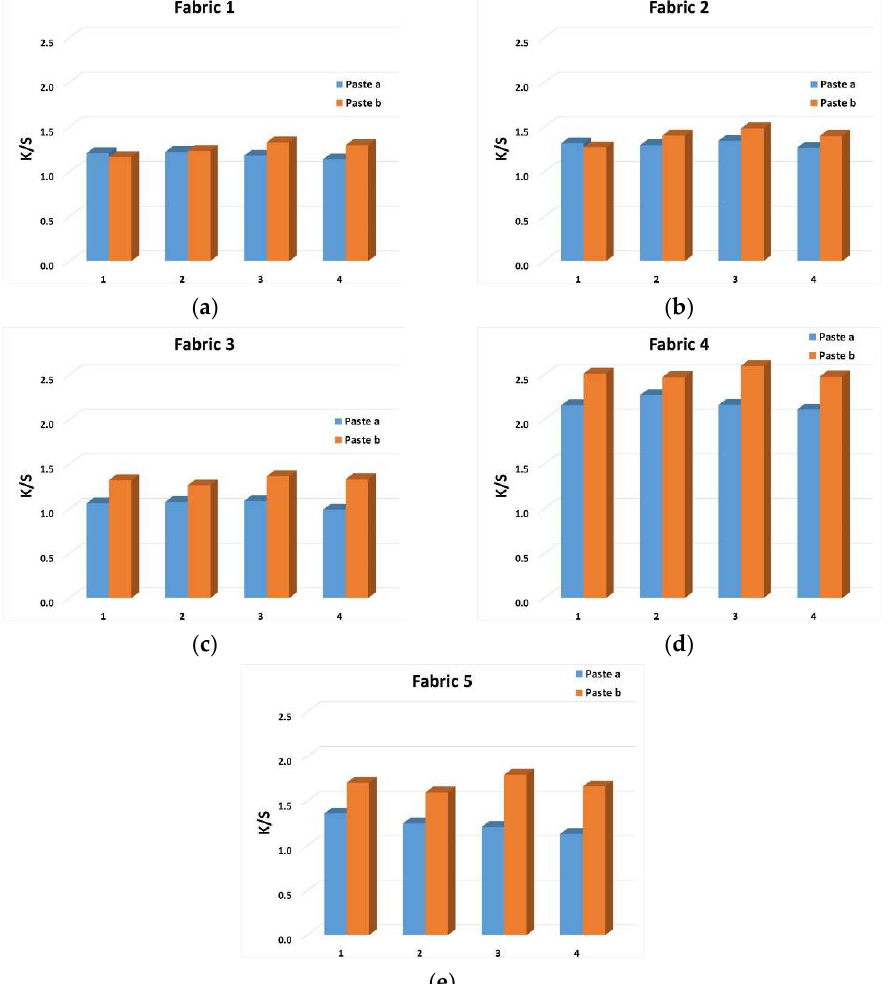
Figure 6. K/S objective values of color of printed surfaces: Fabric 1 ( a ), Fabric 2 ( b ), Fabric 3 ( c ), Fabric 4 ( d ) and Fabric 5 ( e ). Table 7. Lightness (L*) and chroma (C*) relationship for printed samples. as definition of color in- tensity.